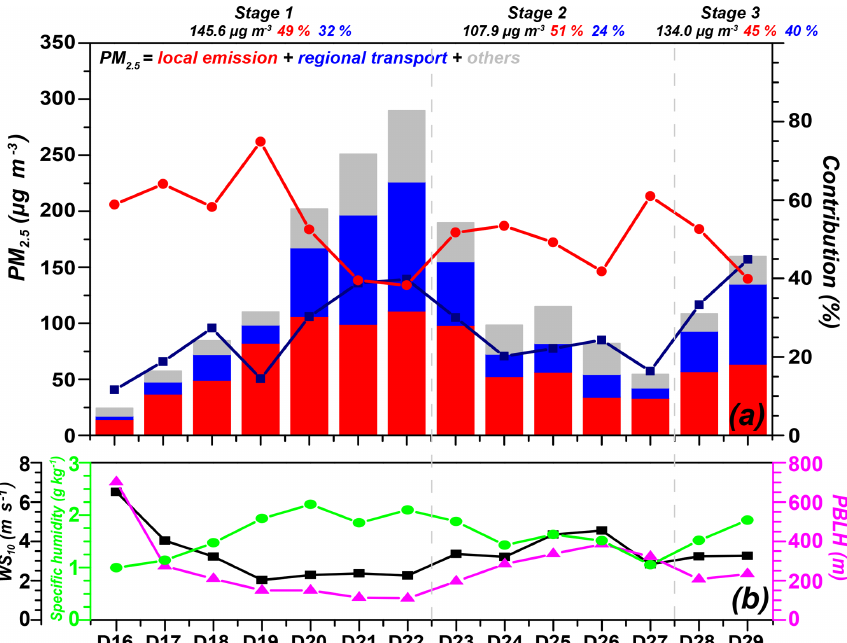
Figure 7. (a) Contributions of local emissions (red) and regional transport (blue) to the near-surface PM 2 . 5 concentrations averaged over the Beijing–Tianjin–Hebei region from 16 to 29 December 2015. The absolute contributions (µgm − 3 ) are shown using bars, and the percentage contributions (%) are shown using lines. The PM 2 . 5 concentration and the percentage contributions averaged over each stage are listed at the top of panel (a) . Simulated daily 10m wind speed (WS 10 ; ms − 1 ; black dotted line), specific humidity (gkg − 1 ; green dotted line), and PBLH (m; magenta dotted line) averaged over Beijing–Tianjin–Hebei are also shown in panel (b)